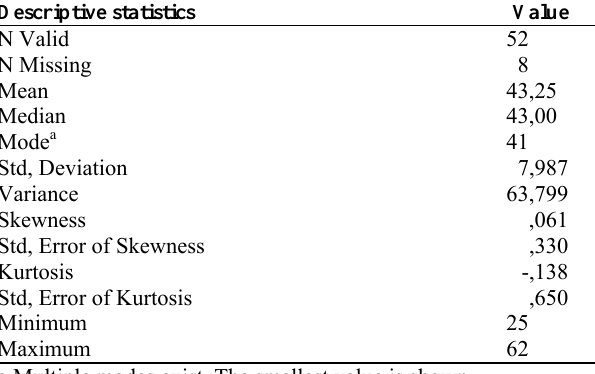
Table 5: Descriptive statistics characterizing the unit